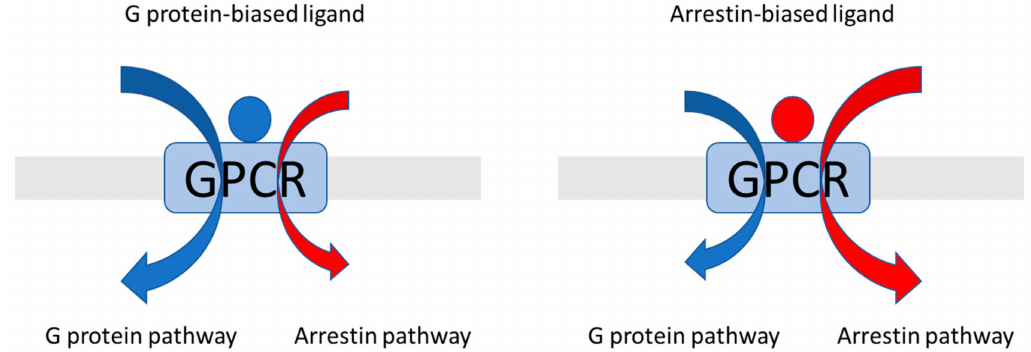
Figure 1. Overview of pathway-biased ligand activation for G protein-coupled receptors